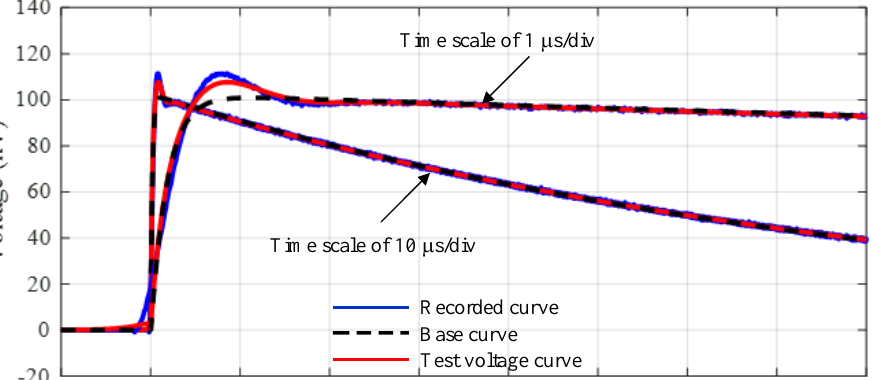
Figure 13. The assessed full lightning impulse waveforms in the LI-X9 case (experimental waveform data).